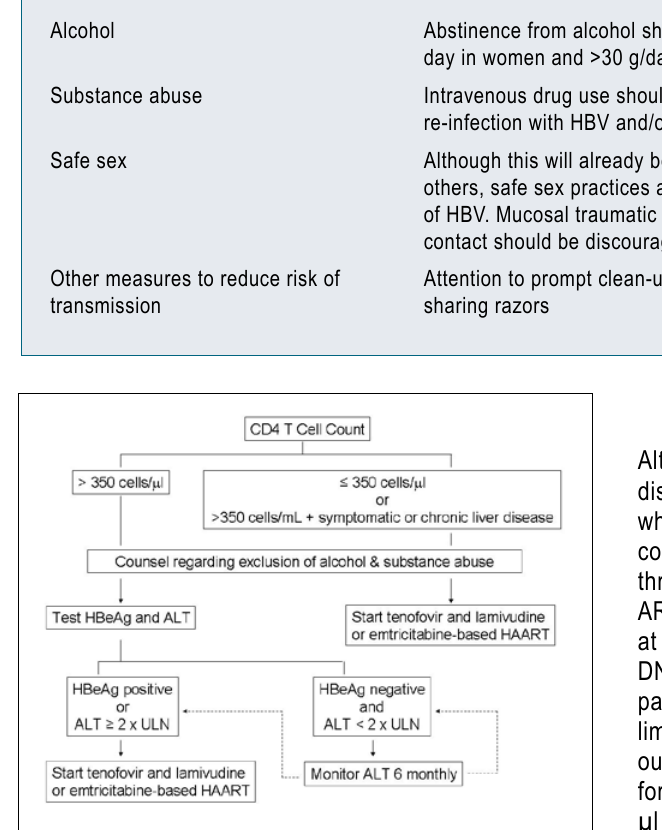
Fig. 1. Algorithm for management of HIV-HBV co-infected